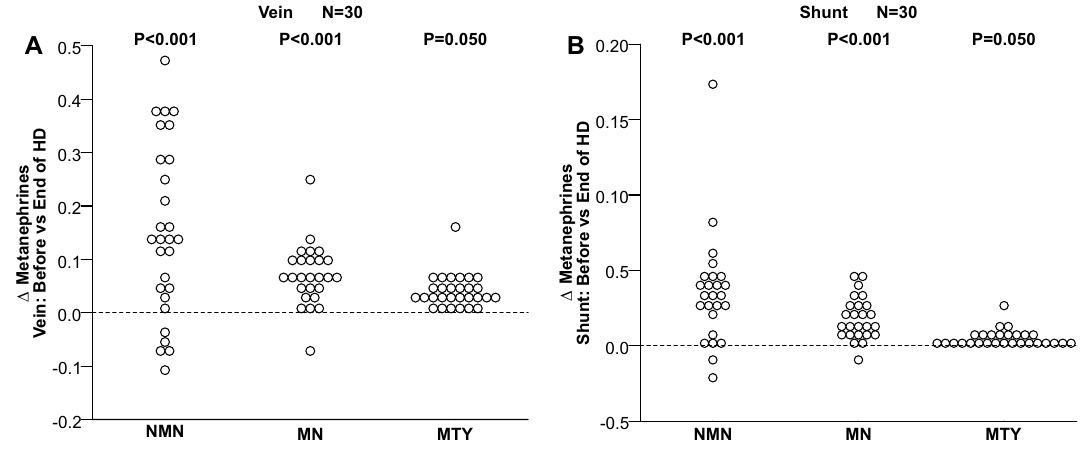
Figure 1. Δ of plasma concentrations of free normetanephrine (NMN), metanephrine (MN) and 3-methoxytyramine (3-MTY) before versus near the end of HD, in shunt ( A ) and in vein ( B